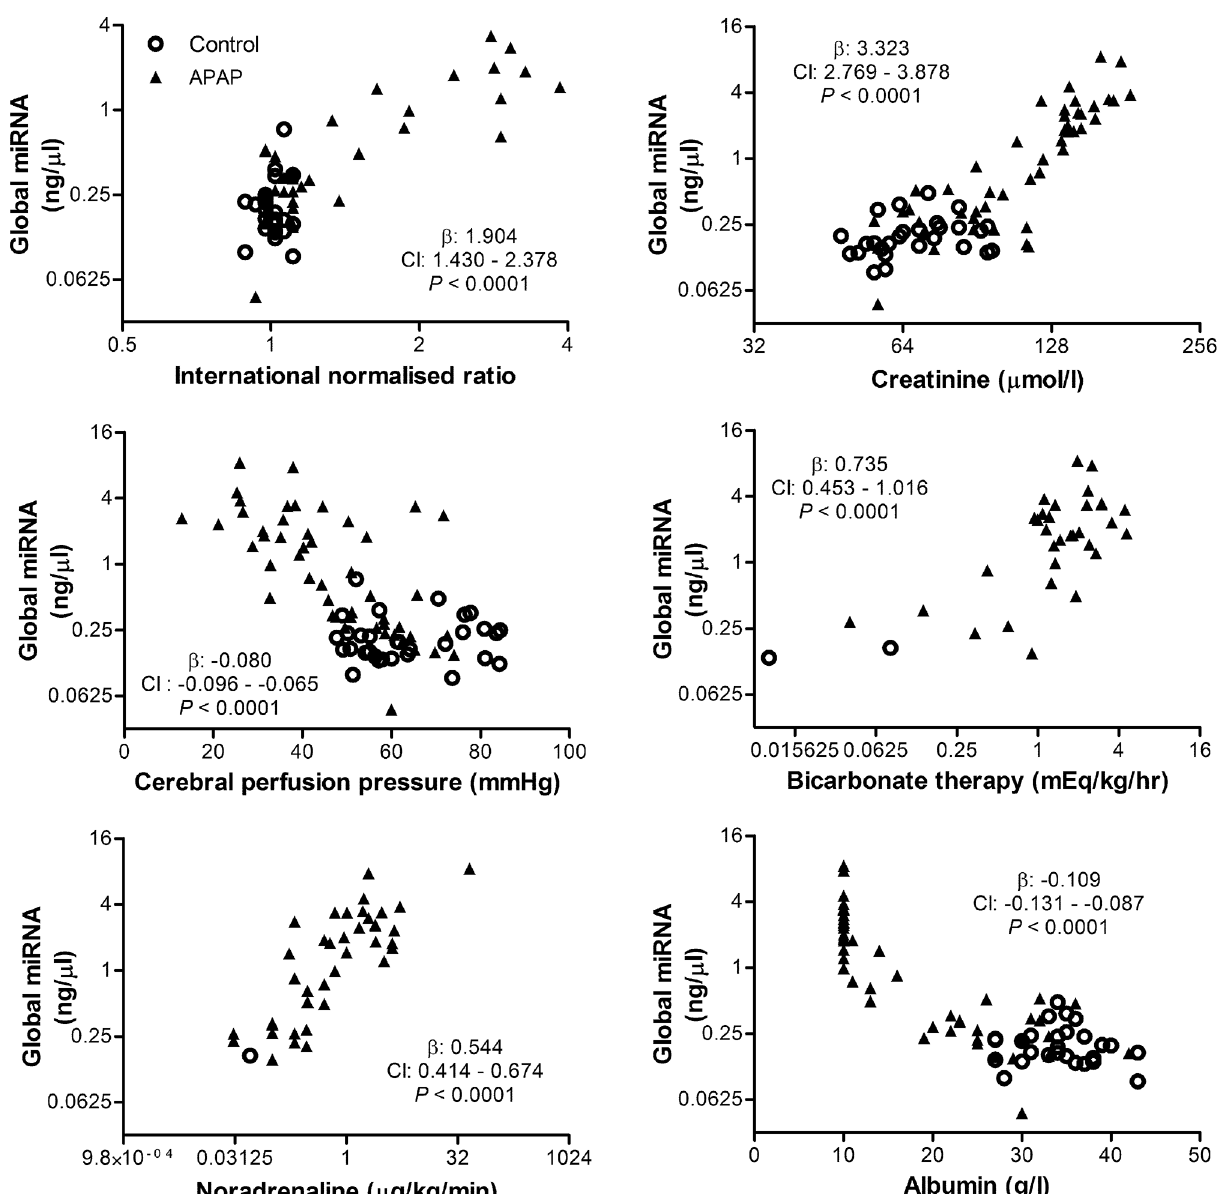
Fig 2. Increasing global miRNA concentrations in plasma associate with parameters of clinical ALF progression. The global miRNA concentrations were compared to six time-matched parameters representing: liver injury; kidney injury; brain injury; acid-base imbalance; cardiovascular stability; vascular permeability. β : fixed effects; CI: confidence